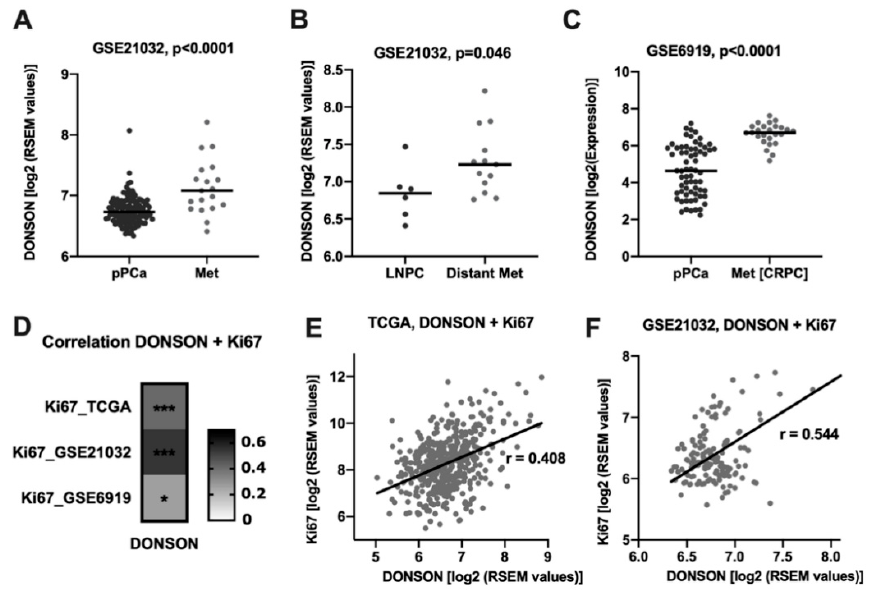
Figure 1. DONSON is associated with clinical-pathological parameters of malignancy and progression-free survival (PFS) using the PCa TCGA dataset ( A ) DONSON expression is enhanced in primary PCa compared to normal adjacent prostatic glands (NAT). DONSON is associated with locally advanced tumor expansion (T Stage), positive lymphonodal metastatic status (N Stage) and the dedifferentiation ISUP score ( B – D ). ( E , F ) DONSON overexpressing PCa exhibit a shortened PFS when analyzing the whole ( E ) or only the clinically relevant ( F ) subgroup of Gleason 7 carcinomas of the PCa TCGA cohort.